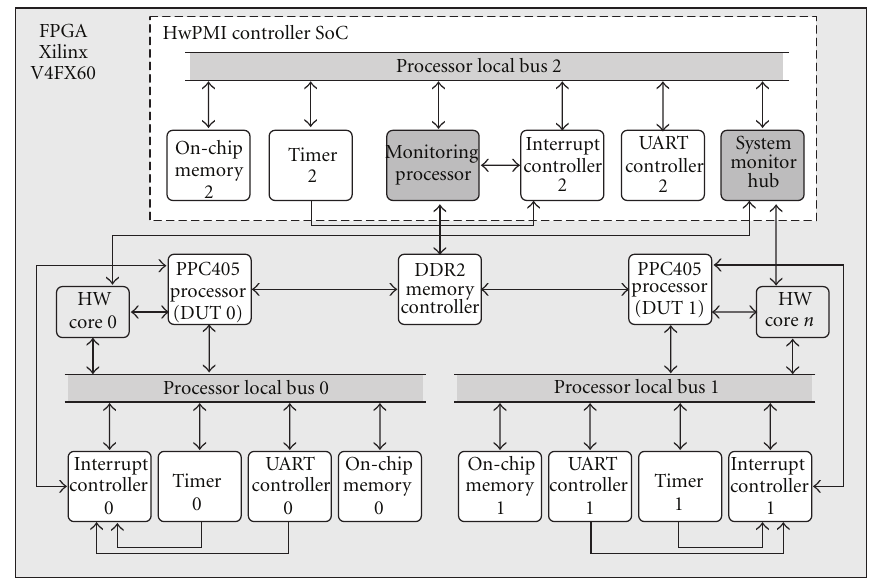
Figure 5: Block diagram of HwPMI System-on-Chip running on embedded device under